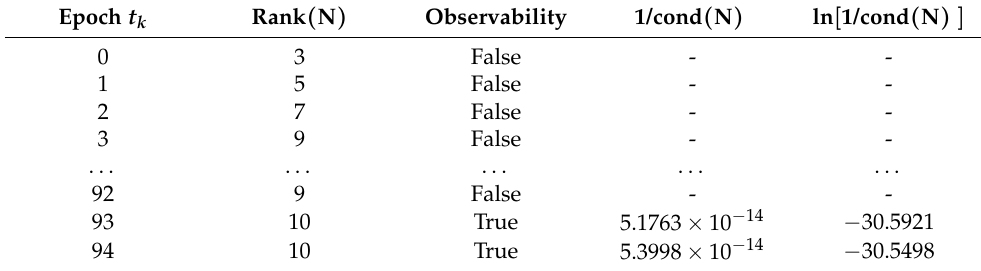
Figure 5. Observability simulation of case II (nonperturbation). Table 3. Observability test results of case II